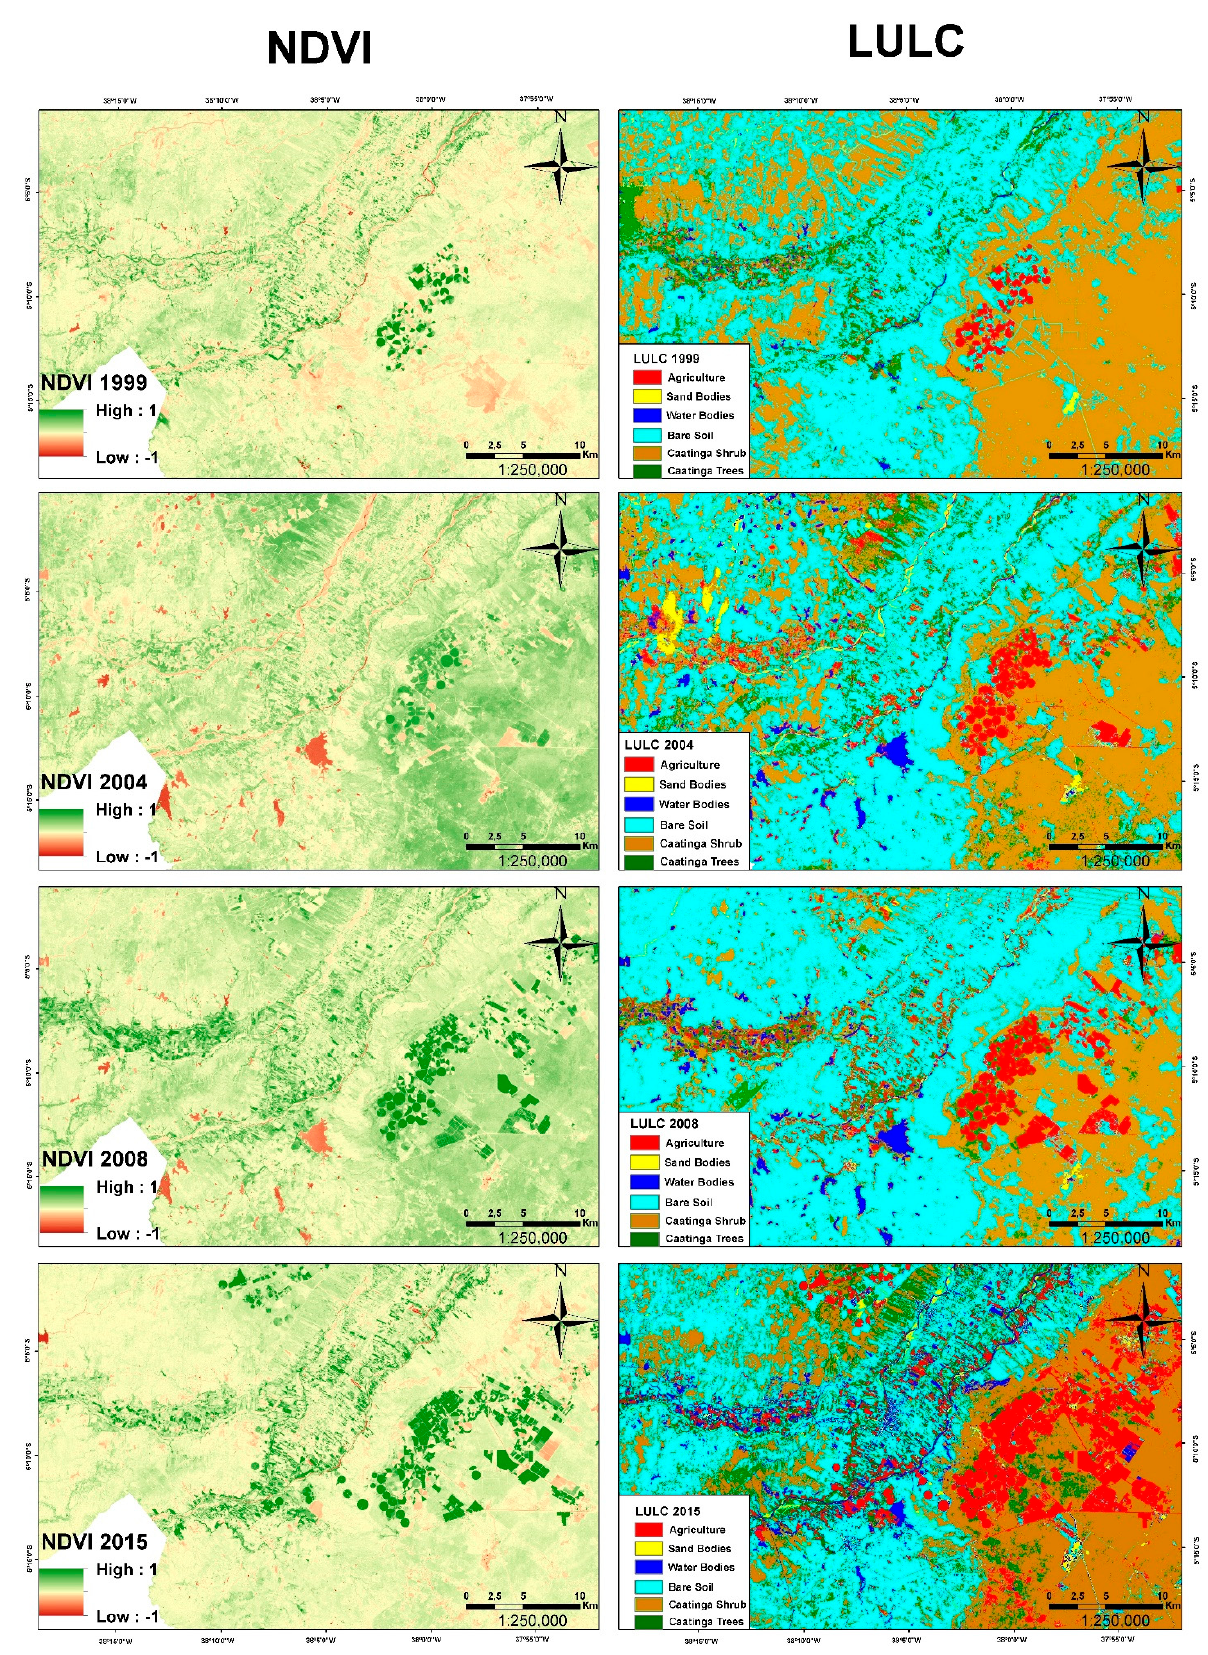
Figure 6. Land use and land cover and NDVI in the LJRSB central-southern region for 1999, 2004, 2008, and